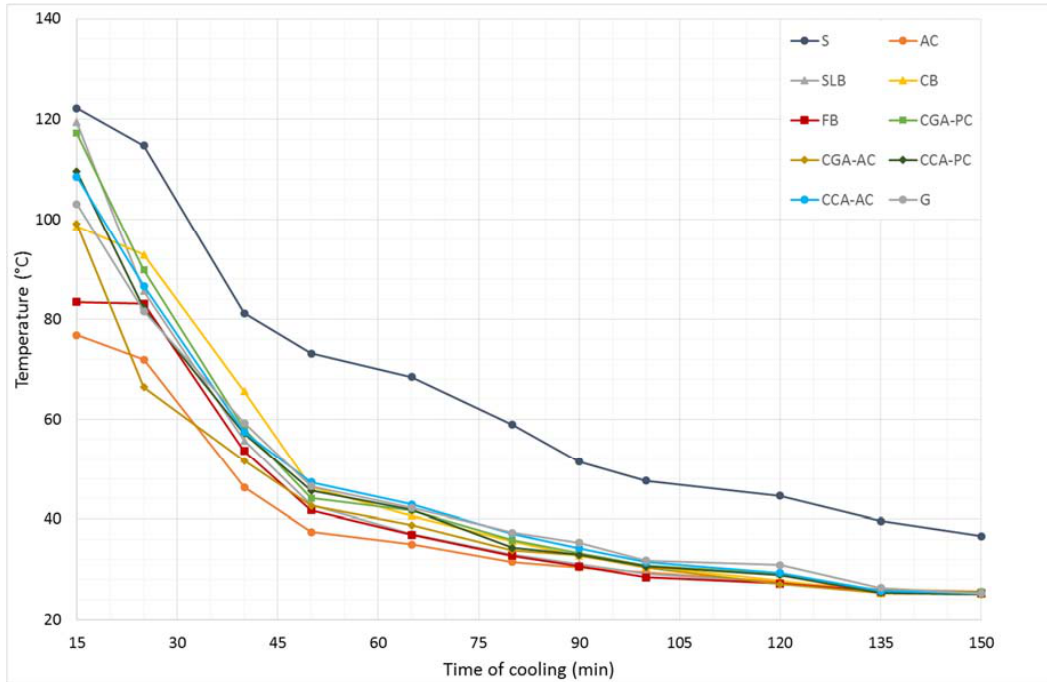
Figure 4. A temperature drop of the materials during cooling on the first stage of the experiment; S: